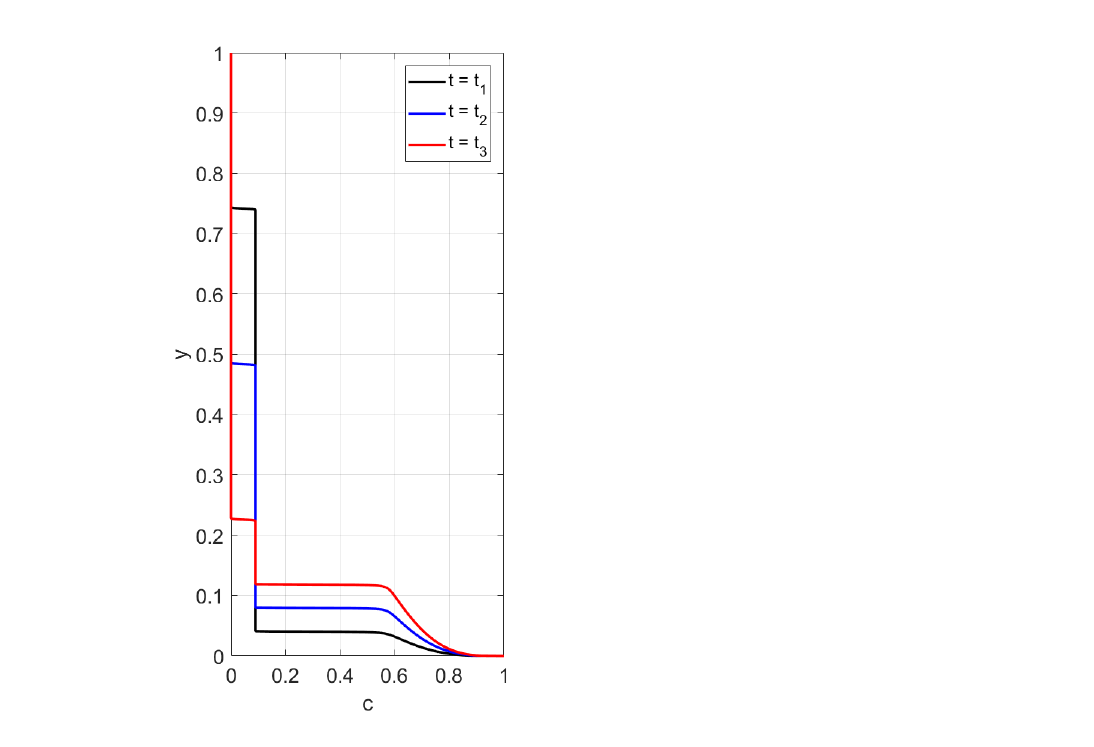
Figure 13. Calculated profiles of the concentration wave at different time instances for the flux F rz ( c ) with m = 4.65. The initial and boundary data are c 0 = 0.09, c bot = 1, c top = 0. The rising discontinuity wave is followed by a centered rarefaction wave.